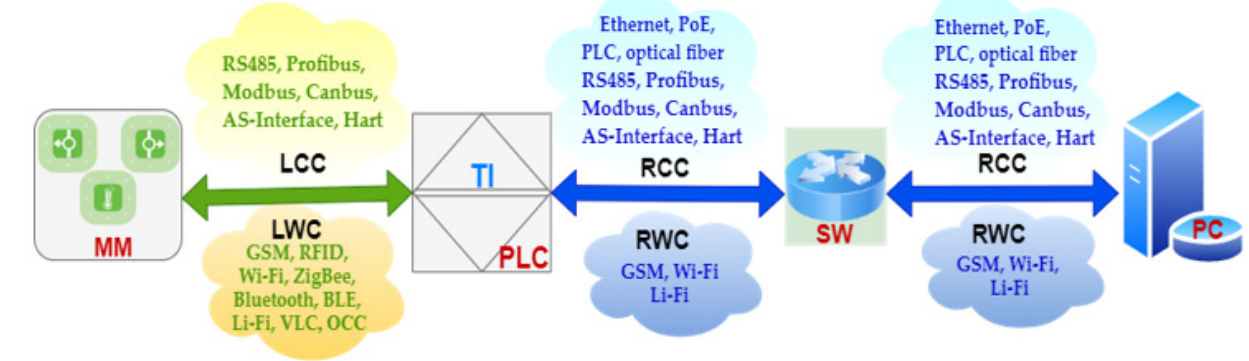
Figure 4. Local and Remote Cabled/Wireless Communication Systems.